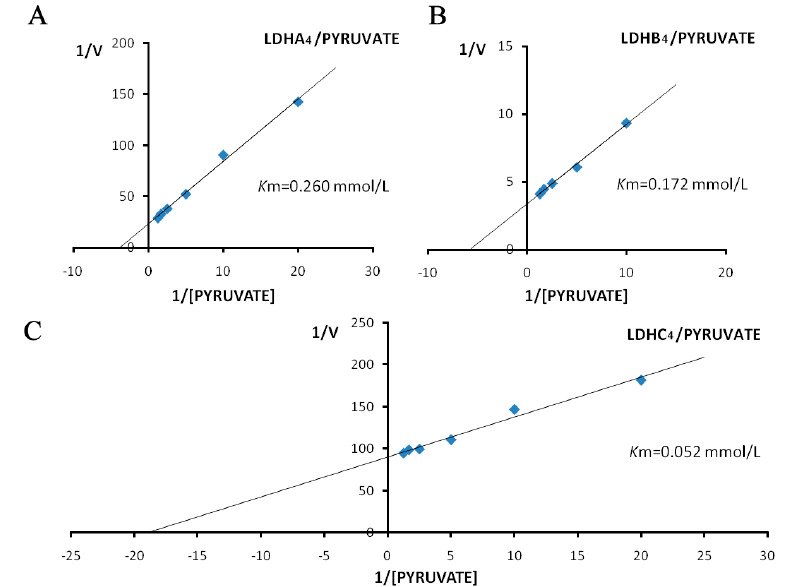
Figure 5. Double reciprocal plots by pyruvate as substrate of plateau pika LDH isozymes. Double reciprocal plots of ( A ) LDH-A 4 ; ( B ) LDH-B 4 ; and ( C ) LDH-C 4 , respectively. Reciprocal velocity ( V ) was calculated with the reciprocal ∆ 340 nm/min, plots were preformed by calculating the reciprocal reaction velocity vs. reciprocal pyruvate concentration at a constant concentration of NADH. The concentrations of pyruvate used were 0.05, 0.1, 0.2, 0.4, 0.6 and 0.8 mmol/L, respectively. NADH concentration was maintained at 0.15 mmol/L. The resulting K m of LDH-A 4 , LDH-B 4 , and LDH-C 4 for pyruvate were 0.260, 0.172 and 0.052 mmol/L, respectively.